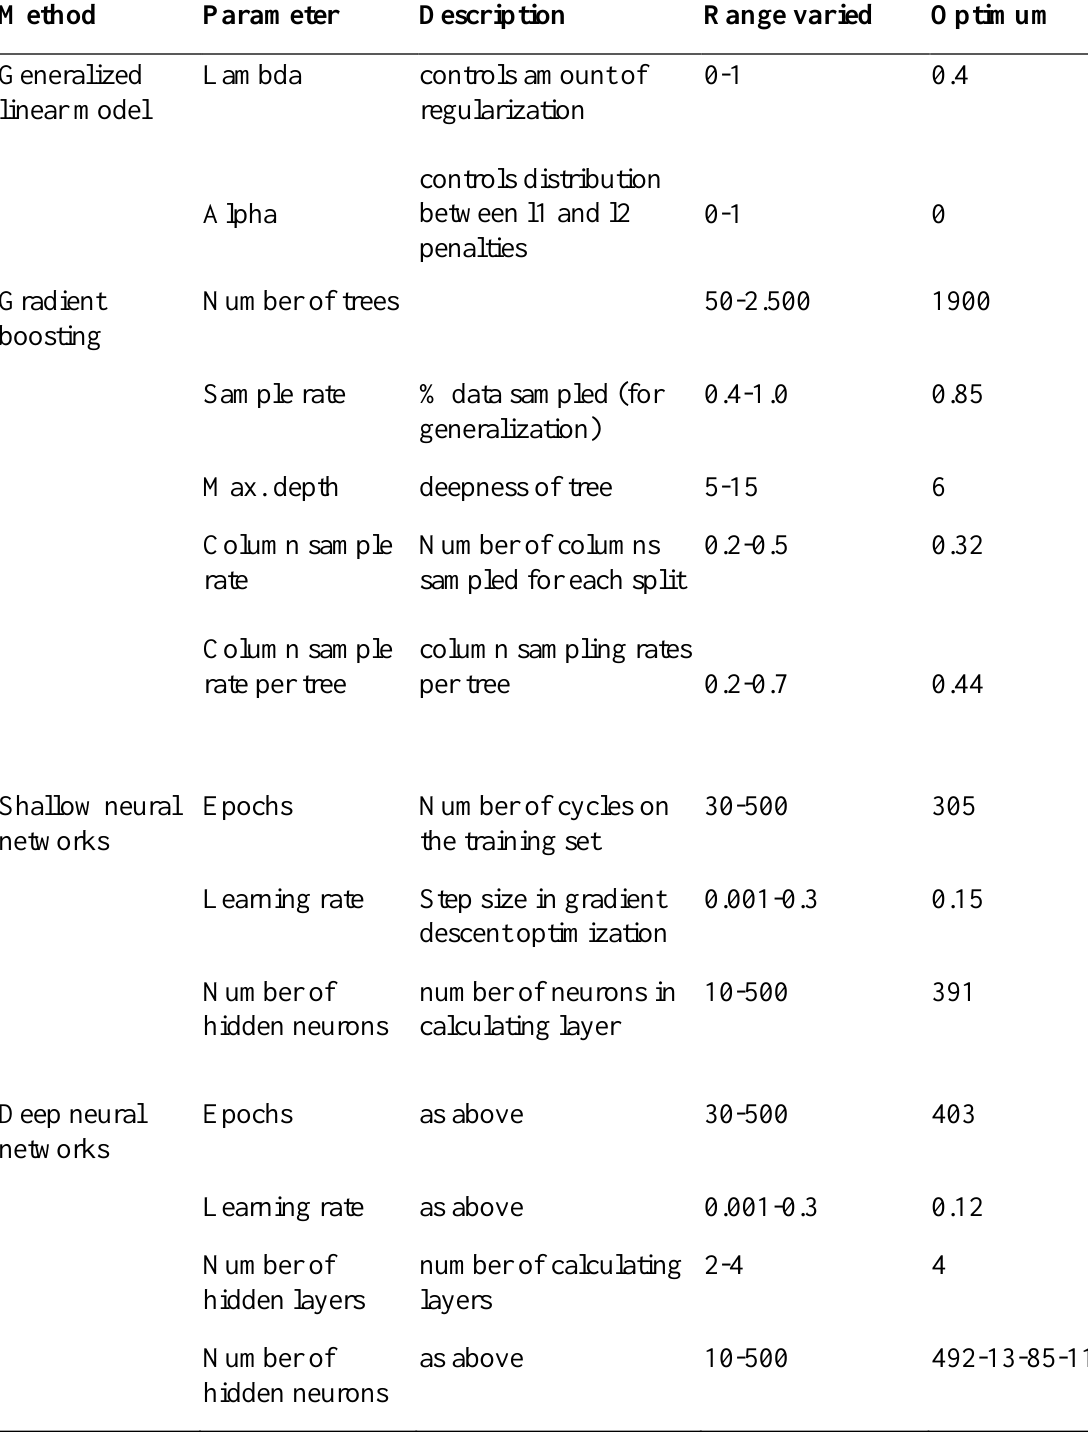
Table A3. Description of parameters varied during grid-search for model-optimization for three machine learning